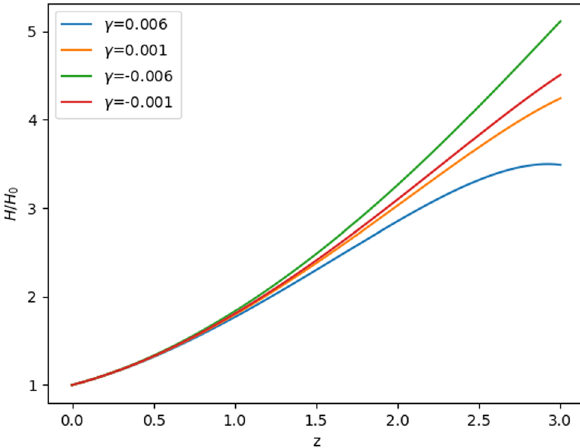
Figure 4: The variation of the deceleration parameter in redshift.